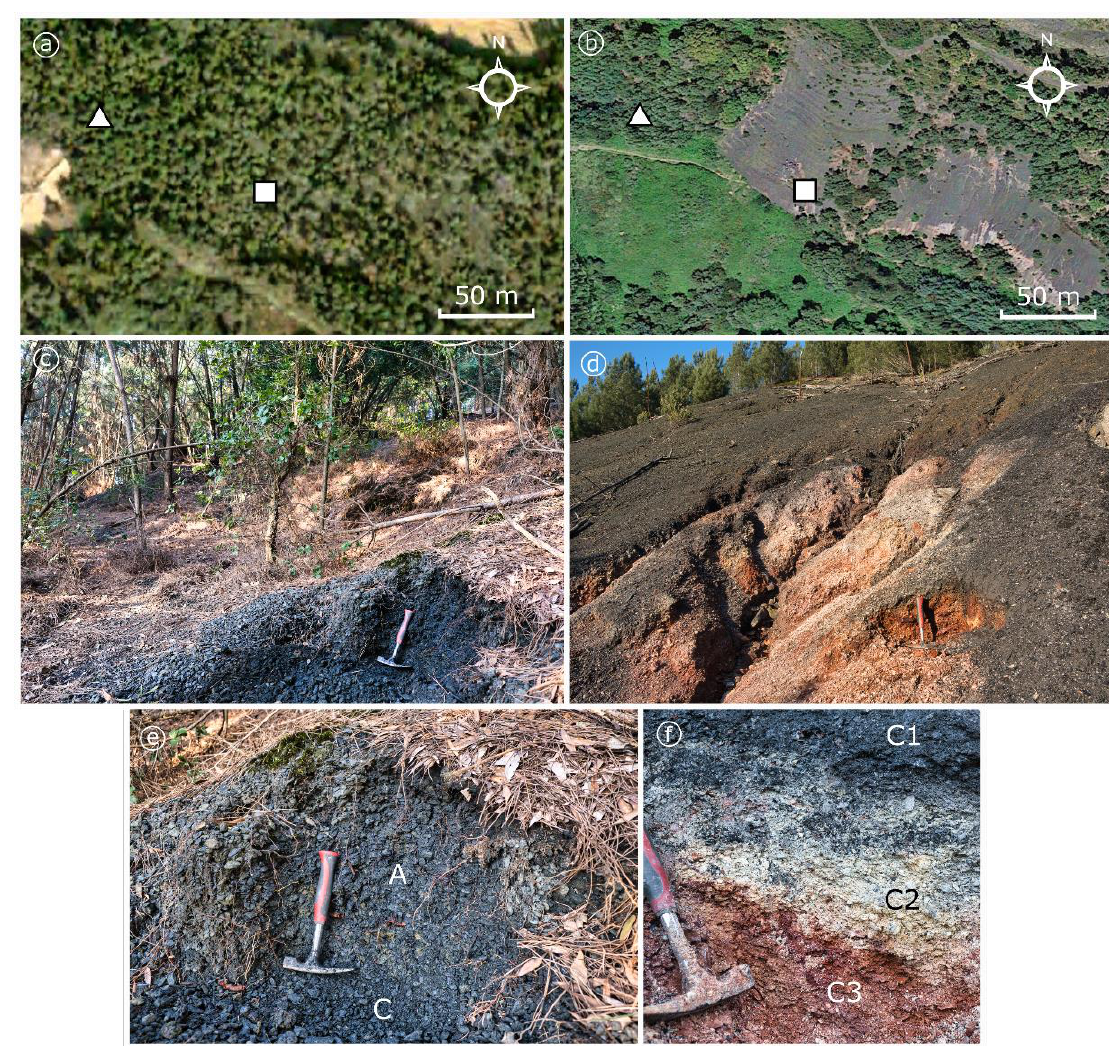
Figure 2. Some aspects of the studied Technosols: ( a ) view of the coal mine waste pile in 2004, before the wildfire; ( b ) view of the coal mine waste pile in 2019; ( c ) waste pile slope with normal pedogenesis; ( d ) waste pile slope affected by self-burning; ( e ) soil profile representing the waste pile with normal pedogenesis (A horizon and C horizon); ( f ) soil profile representing the waste pile affected by self-burning (C1, C2, and C3 horizons). (cid:52) stands for Technosol with normal pedogenesis; (cid:3) stands for Technosol affected by self-burning. Satellite images from Google Earth (21 March 2004; 3 April 2019).